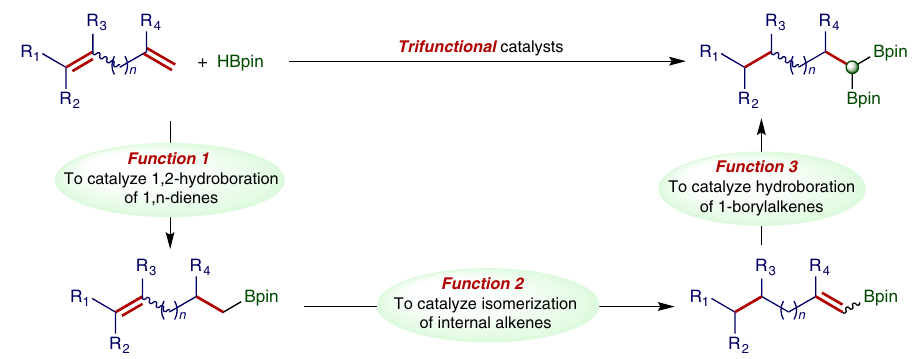
Fig. 1 Hydroboration of dienes. Trifunctional catalysts for chain-walking double hydroboration